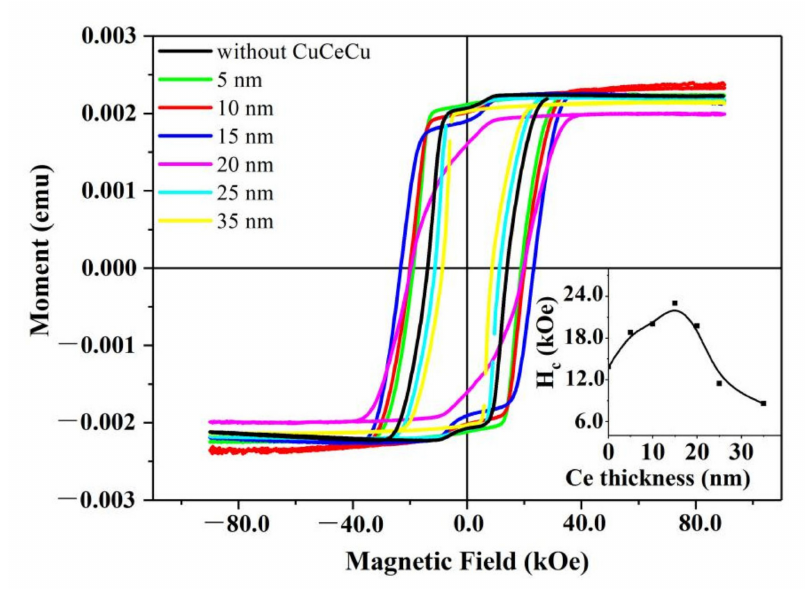
Figure 5. Perpendicular magnetic hysteresis loops of Ta(50 nm)/Nd 6.19 Ce 7.98 Fe 75.48 B 10.35 (200 nm)/Cu(1.5 nm)/Ce(t Ce nm)/Cu(1.5 nm)/Ta(50 nm) films (t Ce = 5, 10, 15, 20, 25, 35) and Ta(50 nm) Nd 6.19 Ce 7.98 Fe 75.48 B 10.35 (200 nm)/Ta(50 nm) film (named without CuCeCu), and the corresponding coercivity values were shown in the